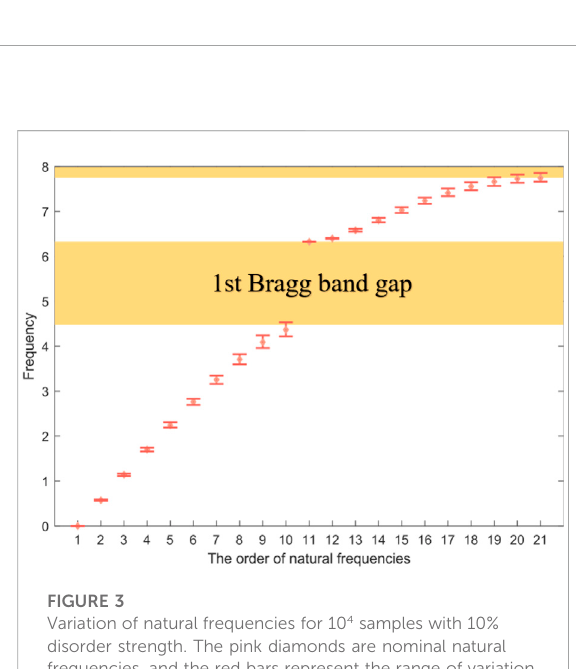
FIGURE 3 Variation of natural frequencies for 10 4 samples with 10% disorder strength. The pink diamonds are nominal natural frequencies, and the red bars represent the range of